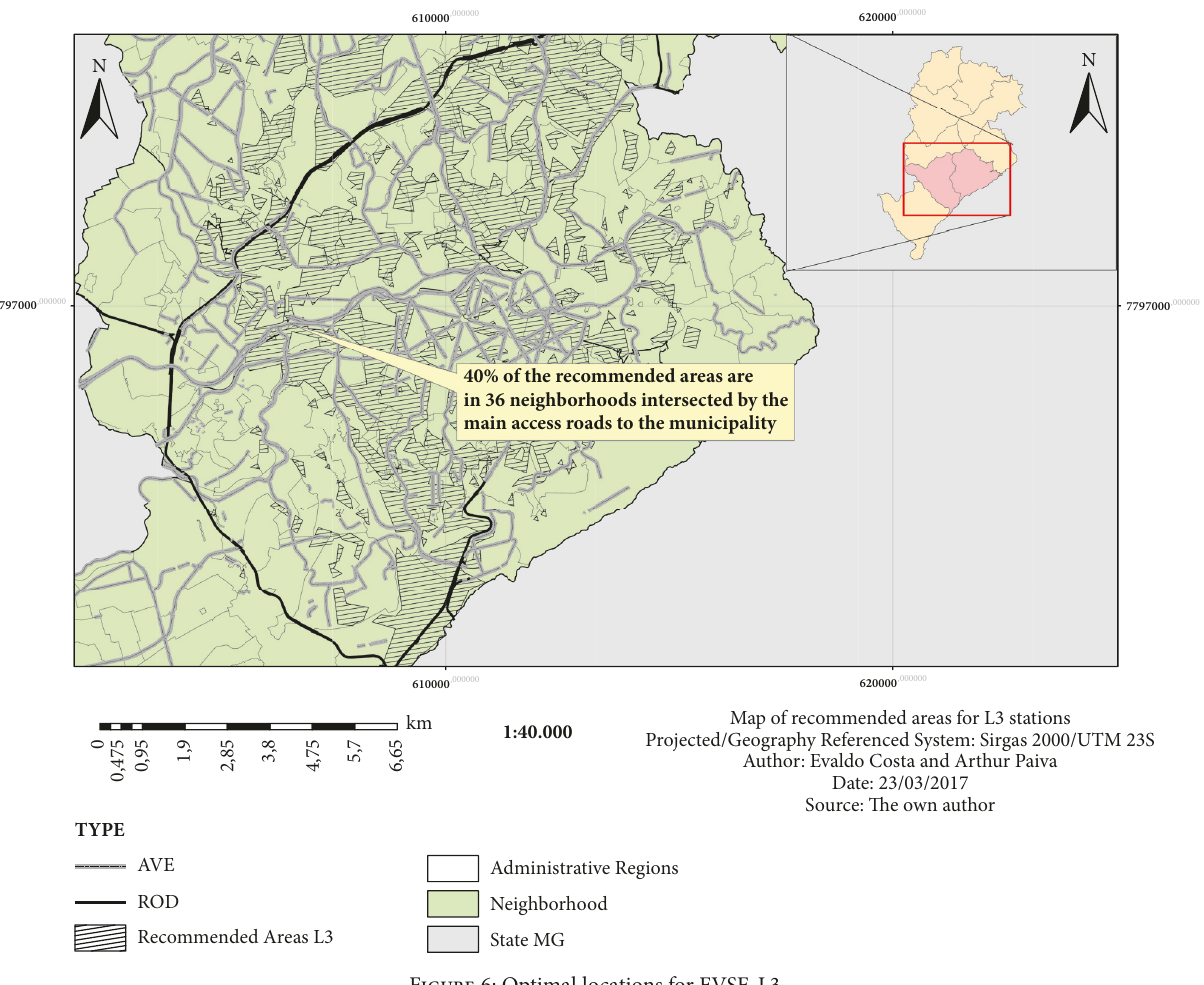
Figure 6: Optimal locations for EVSE